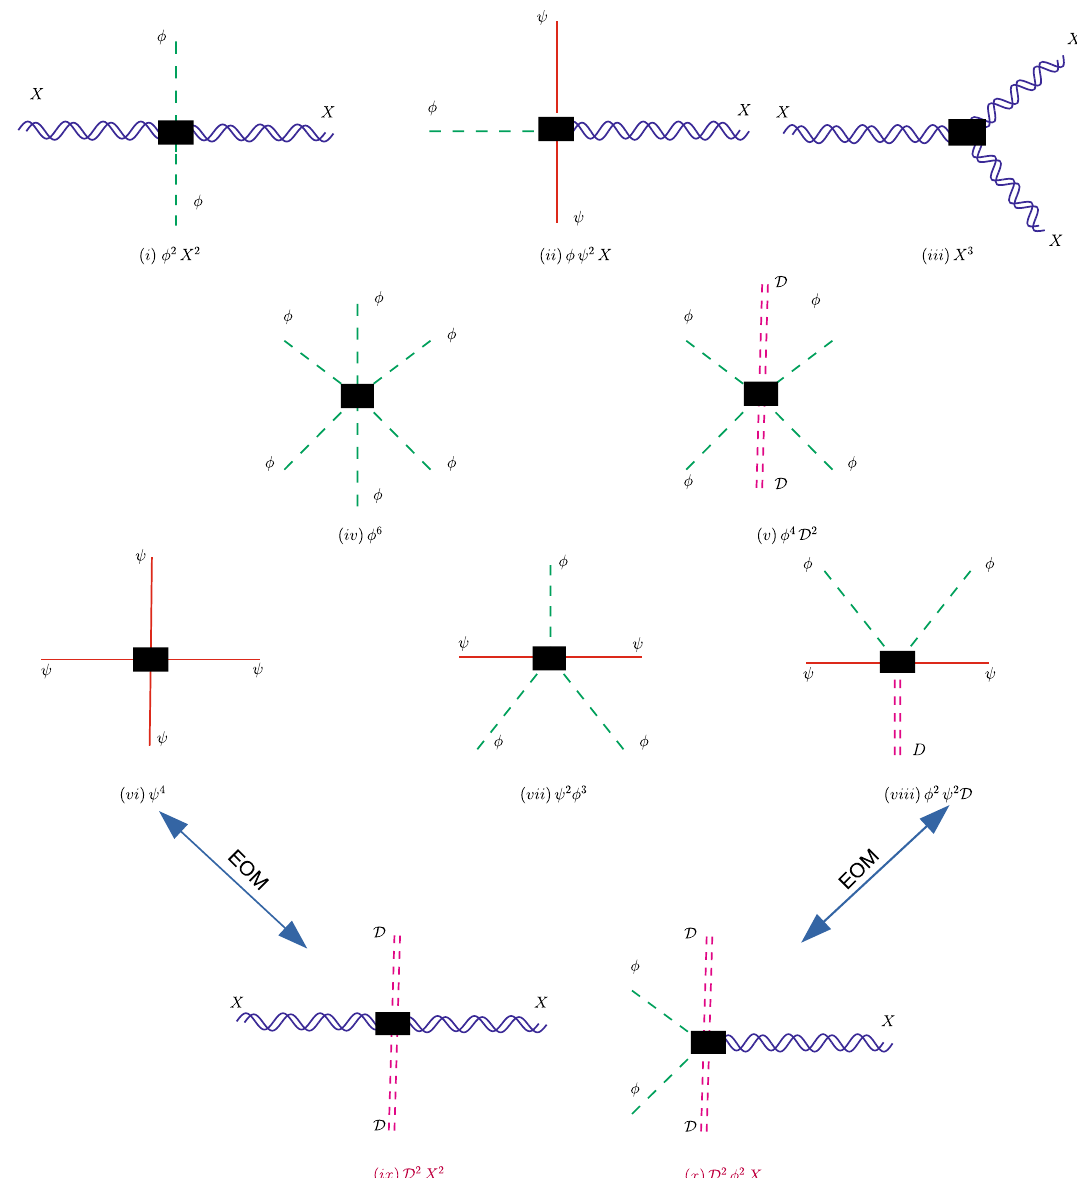
Fig. 3 Diagrammatic representation of mass dimension-6 (for 3 + 1 space-time dimensions) SM operators classes constituted by combining spin-0 ( φ ), spin-1/2 ( ψ ) and Field Strength Tensor ( X ) of spin-1 fields and the covariant derivative ( D ). Operators described by (ix) and (x) are related to (v i ) and (v iii ) respectively through the equation of motion of the gauge fields. Based on which terms are included in the operator